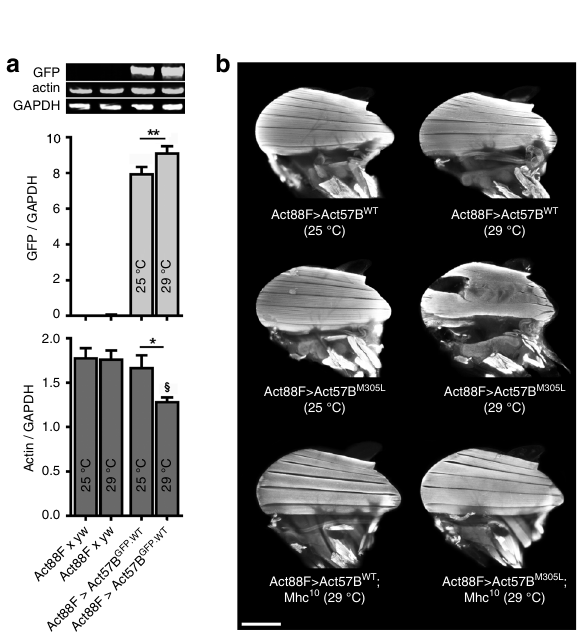
Fig. 4 High dose overexpression of M305L cardiac actin disrupts the